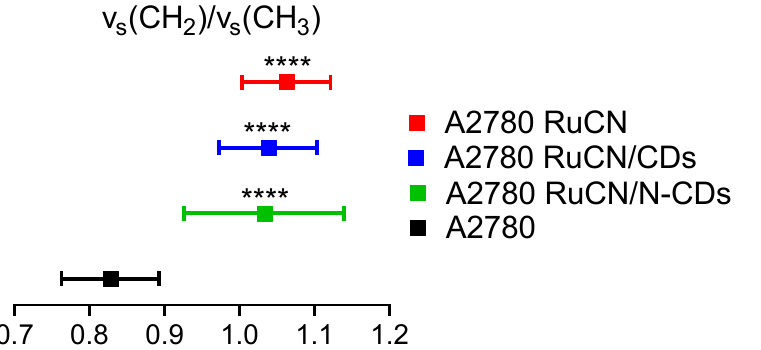
Figure 6. The ratios between symmetric CH 2 and CH 3 bands ( ν s (CH 2 )/ ν s (CH 3 )). The values are presented with the mean ± SD. All the values are compared to the control (A2780 untreated cells, black color), and **** indicates values that are significantly different ( p ≤ 0.0001).